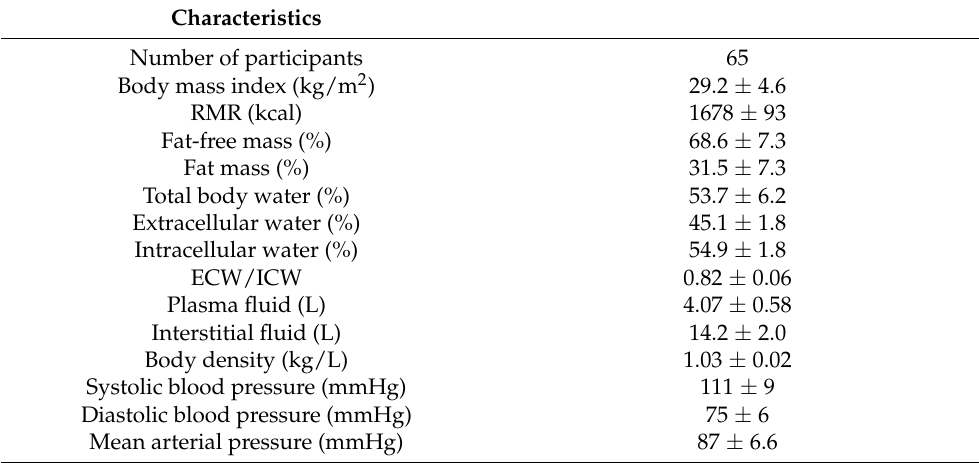
Table 2. Healthy pregnant women body composition, body fluid status, and arterial blood